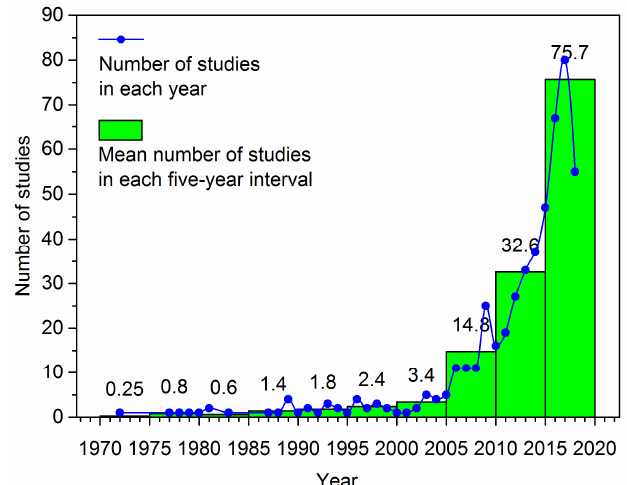
Figure 1. Number of studies in each year and the mean number of publications in each five-year interval. Note that the final year (2018) has data only for eight months (January–August).